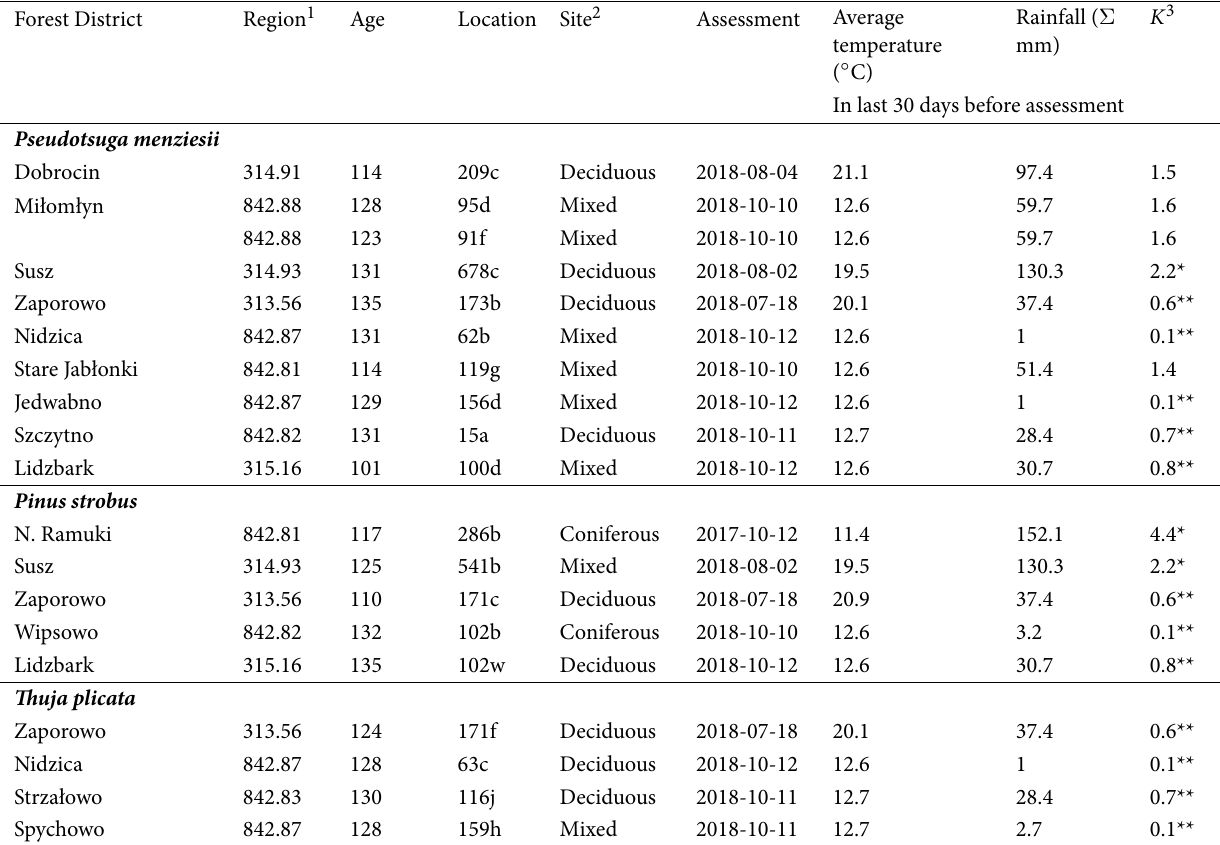
Table 1 Characteristics of plots with introduced tree species in the Forest Districts and average monthly temperature and rainfall and values of hydrothermal coefficient K .